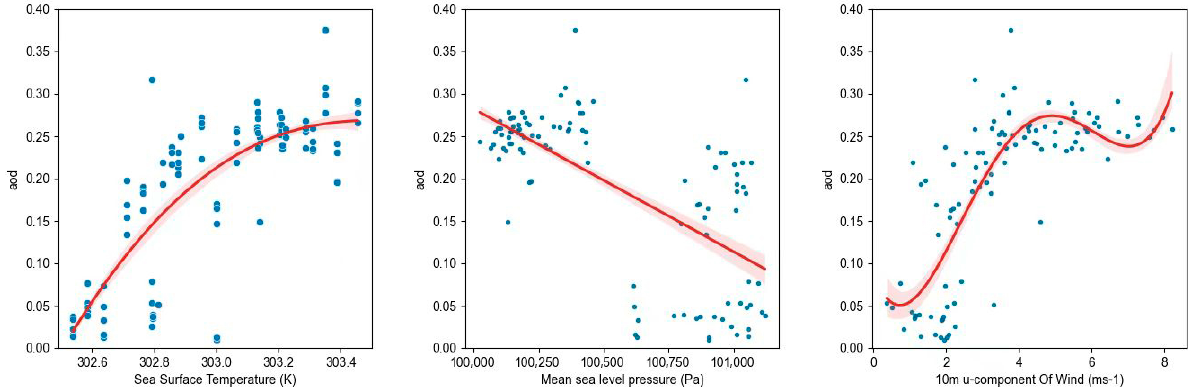
Figure 10. AOD-meteorological relation in summer.